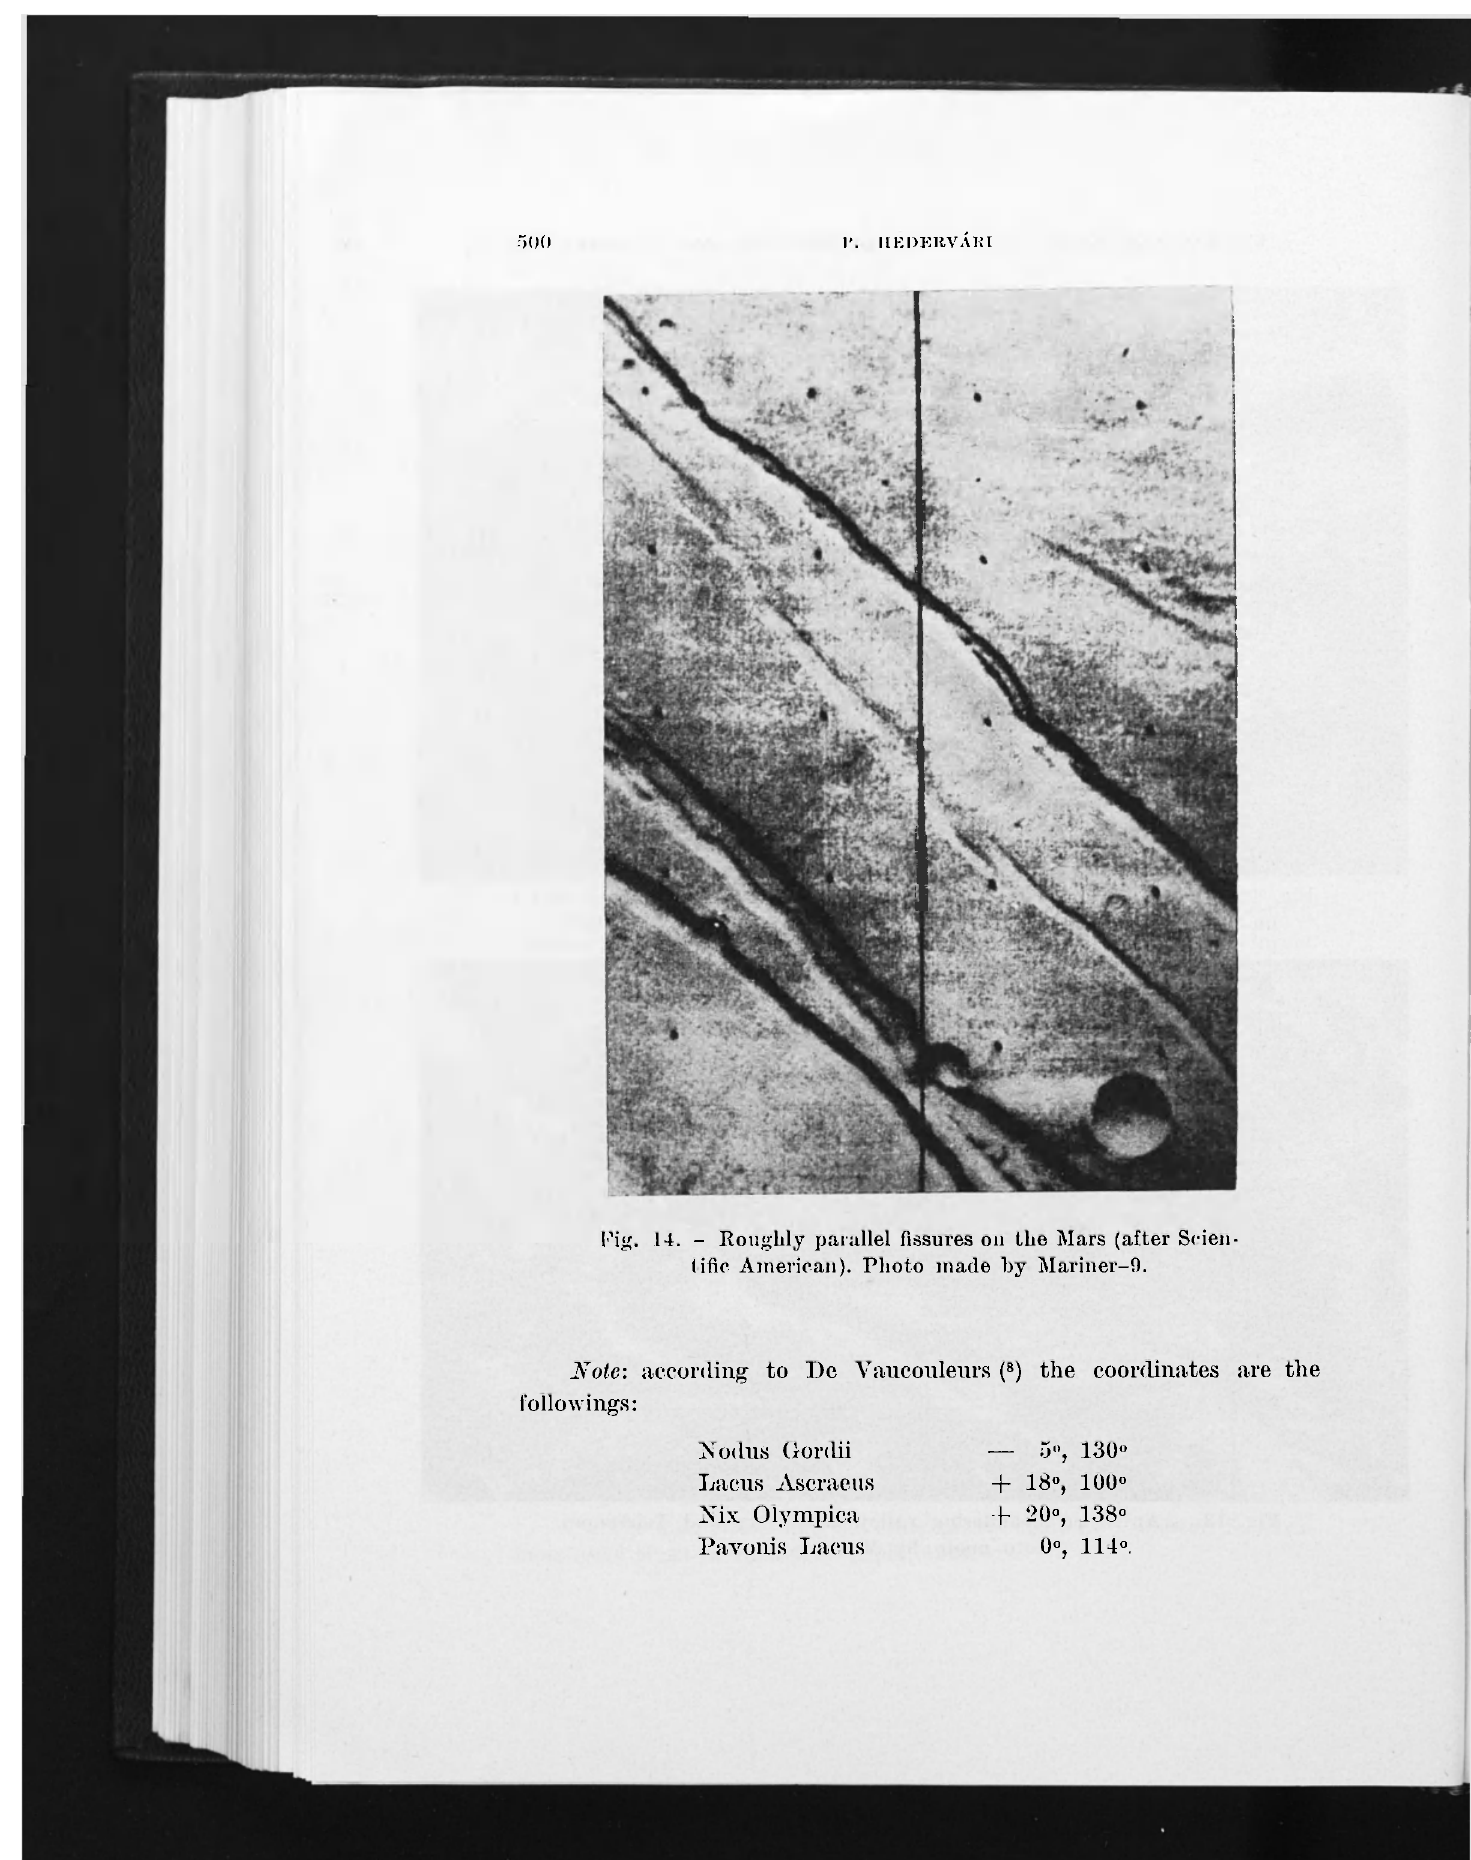
Fig. 14. - Roughly parallel fissures on the Mars (after Scien- tific American). Photo made by